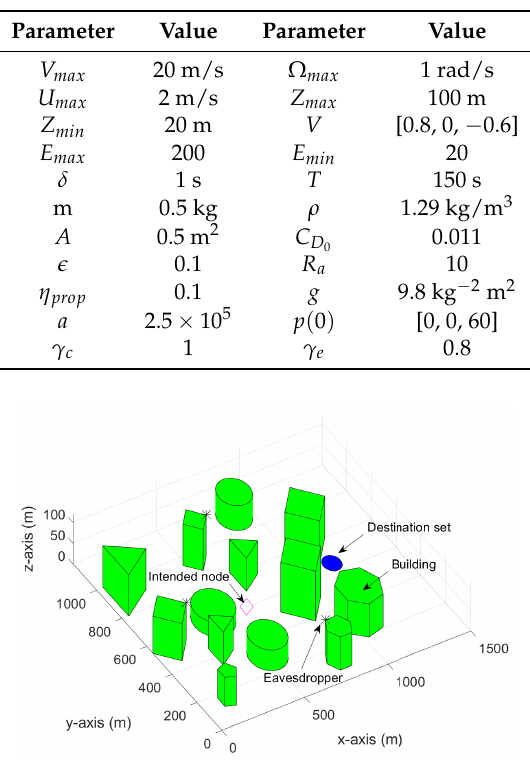
Figure 4. The simulated urban environment.